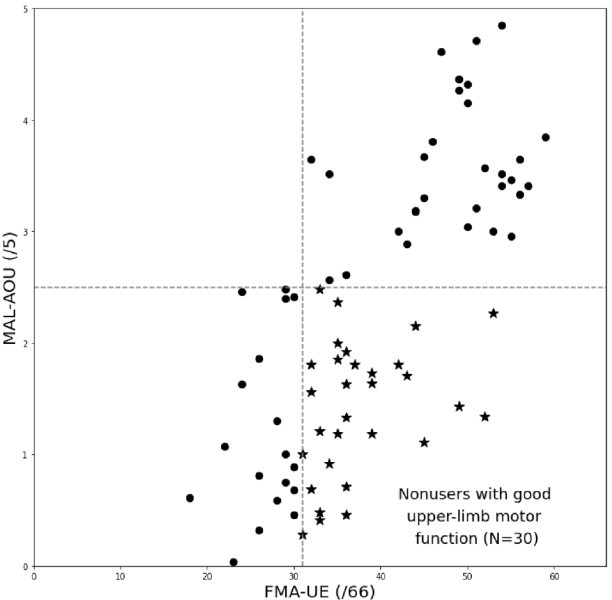
Figure 2. Scatterplot of the grouping schema. The stars( ★ ) in the graph represent participants in Group 1 (nonuse with good arm motor function), and the dots( ● ) represent those in Group 2 (all others).